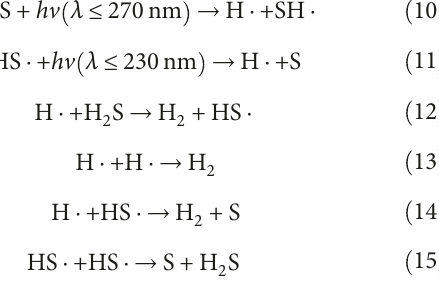
S degradation rate and 2